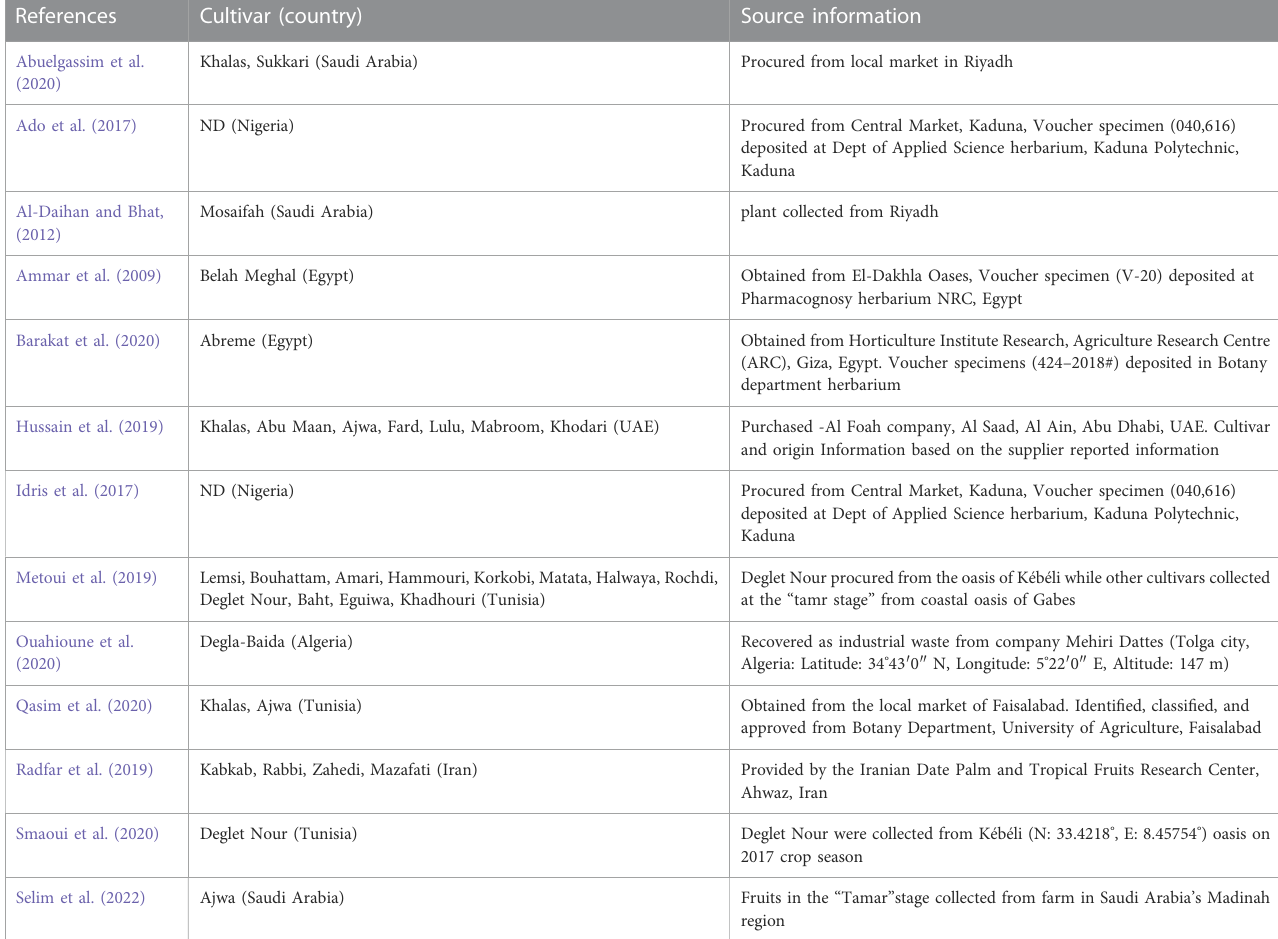
TABLE 5 Overview of selected records reporting antibacterial activity of polyphenols sourced from date kernel